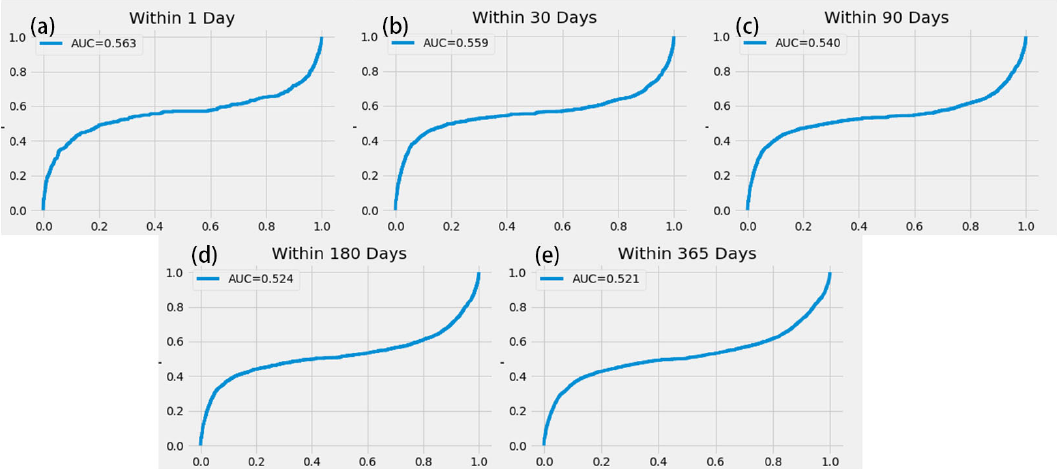
Figure 3. ROC curve of (cid:49) CFS for multiple timescales. Panels (a) through (e) show the ROC curve of the model within 1, 30, 90, 180 and 365d, respectively. The horizontal axis represents the FPR (false positive rate), and the vertical axis represents the TPR (true positive rate).